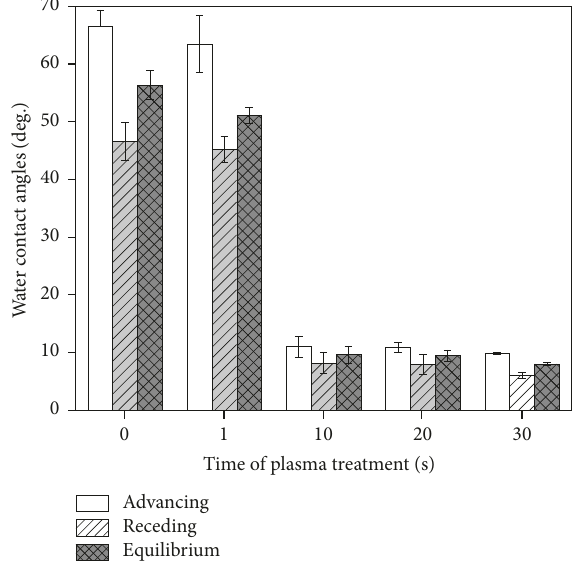
Figure 2: Advancing and receding water contact angles measured on the paper composite